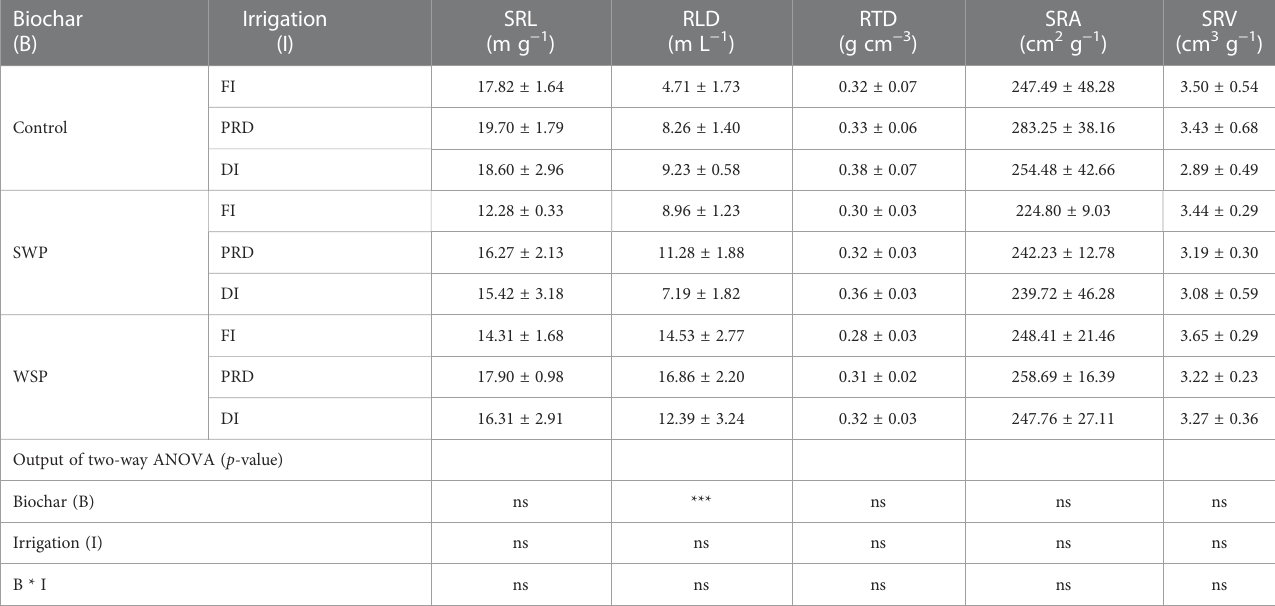
TABLE 3 The effects of treatments and output of two-way ANOVA for speci fi c root length (SRL), root length density (RLD), root tissue density (RTD), speci fi c root area (SRA), and speci fi c root volume (SRV) of maize plants. Biochar